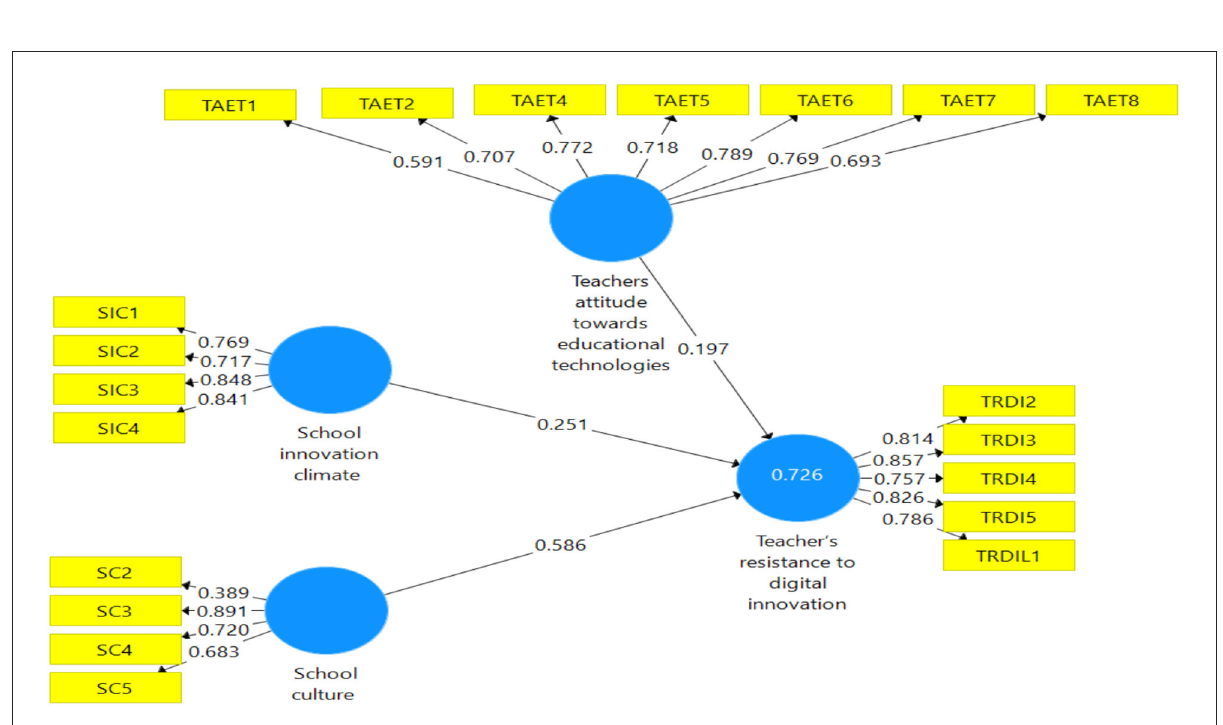
FIGURE2 Assessment of PLS